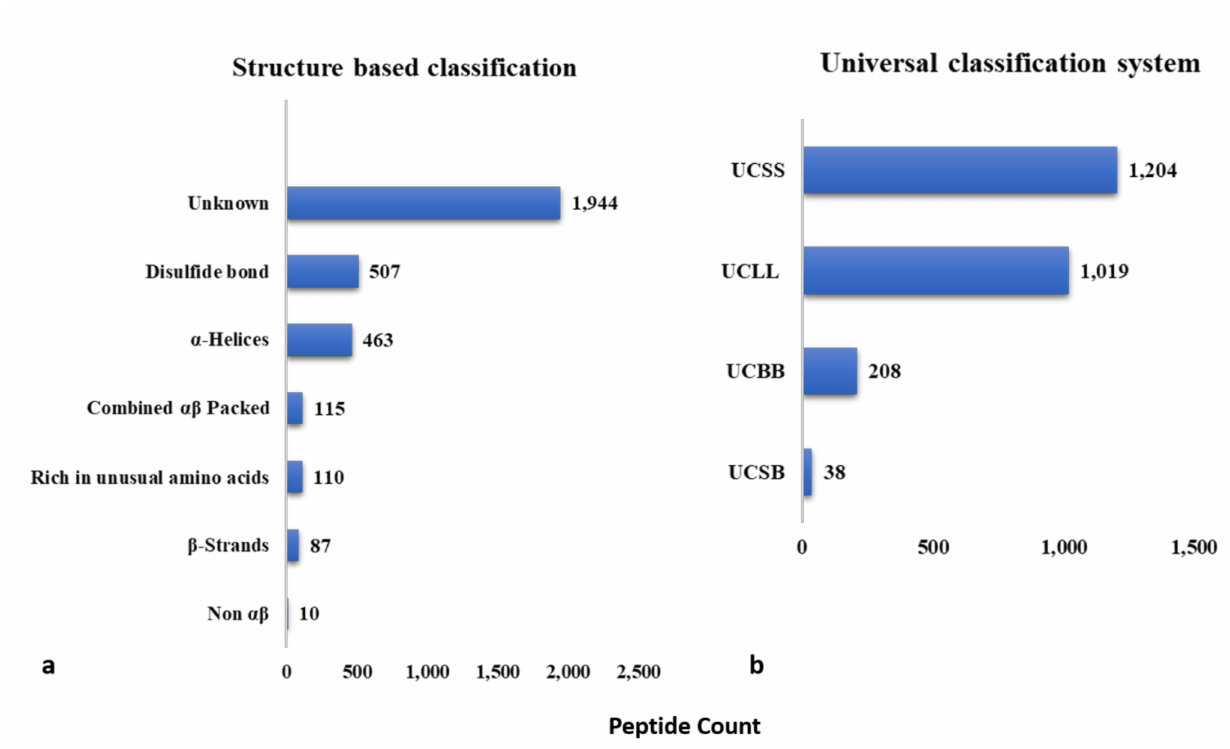
Figure 6. ( a ) Number of AMP 3D structures and ( b ) the AMP universal classification system. The x-axis represents the peptide count and, the y-aixs, the strucutre and class of